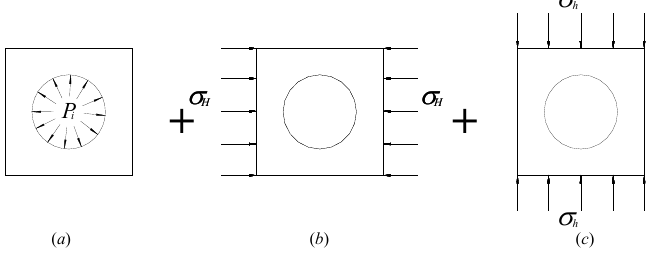
Figure 6. Two ‐ dimensional mechanic model of shaft wall rock .